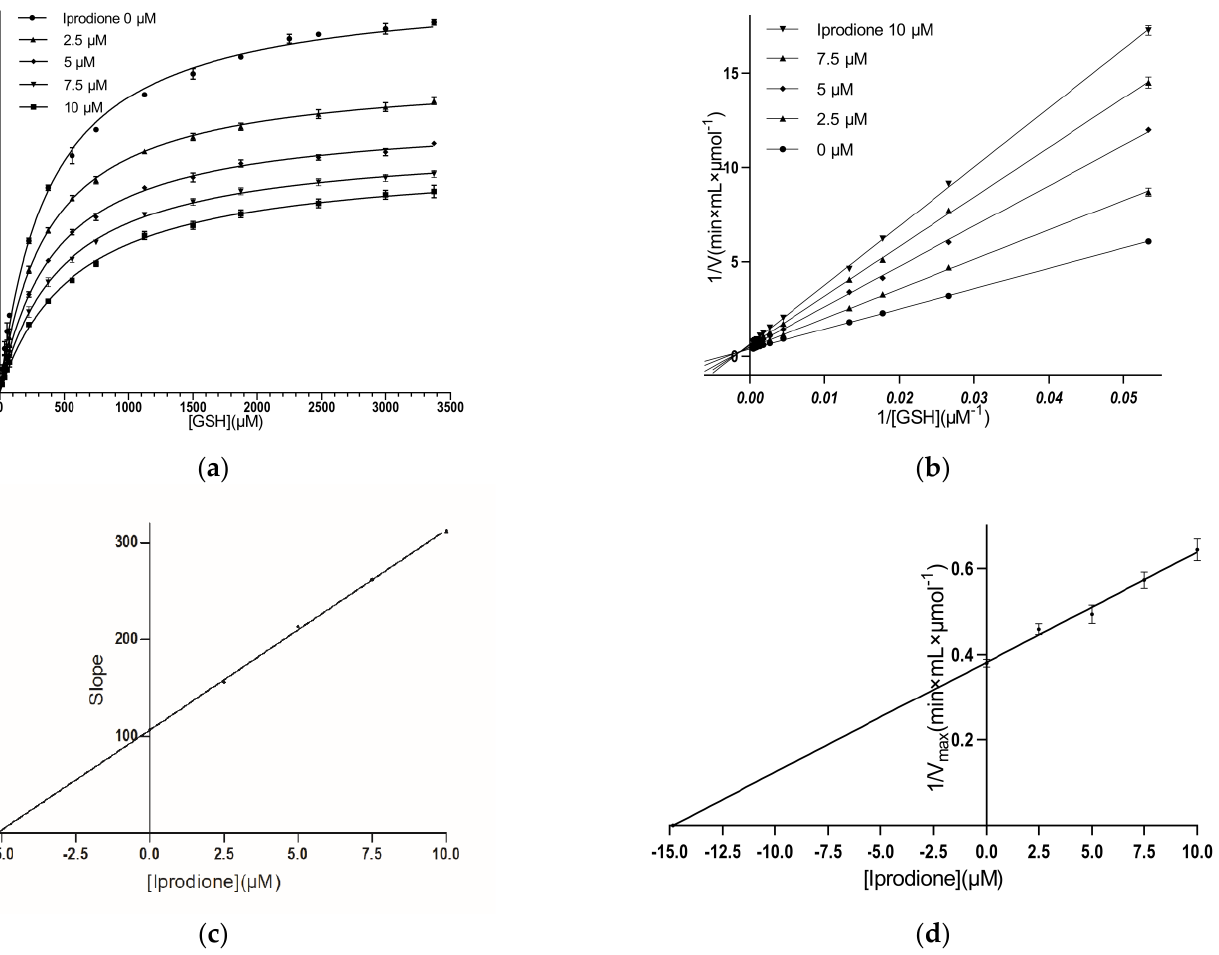
Figure 4. Kinetic inhibition of Mm GSTP1 − 1 by iprodione. The concentration of CDNB was constant, while the concentration of GSH was varied. ( a ) Michaelis – Menten plot and ( b ) Lineweaver – Burk plot for the inhibition of Mm GSTP1-1 with iprodione at different GSH concentrations. Iprodione concentrations: 0 − 10 μΜ. ( c ) Secondary plot for the determination of K iE for the GSH. The slope values were obtained from a Lineweaver – Burk plot. ( d ) Secondary plot for the determination of K iES for the GSH. The 1/V max values are the intersection points of lines on the ordinate axis of the Lineweaver – Burk plot.